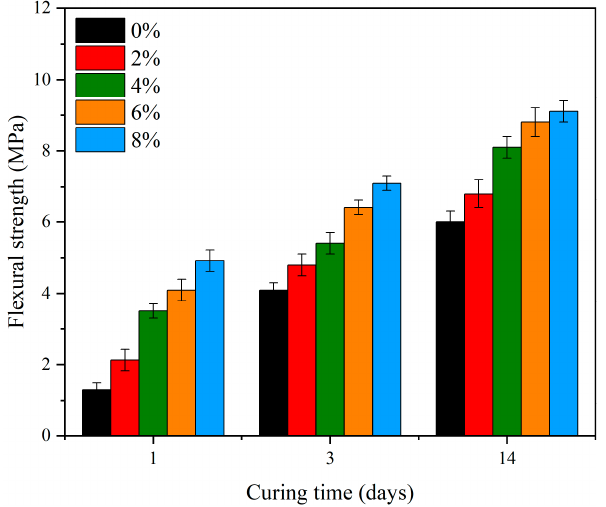
Figure 5. Flexural strength of cement samples with ultrafine calcium silicate.